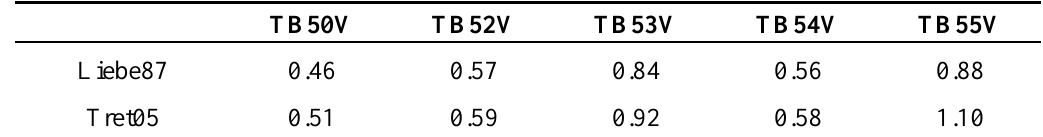
Table 1. Root mean square difference (in K) between simulations and measurements for Liebe87 and Tret05 models used for the oxygen absorption at SSMIS oxygen band channels. Turn09 is used for water vapor